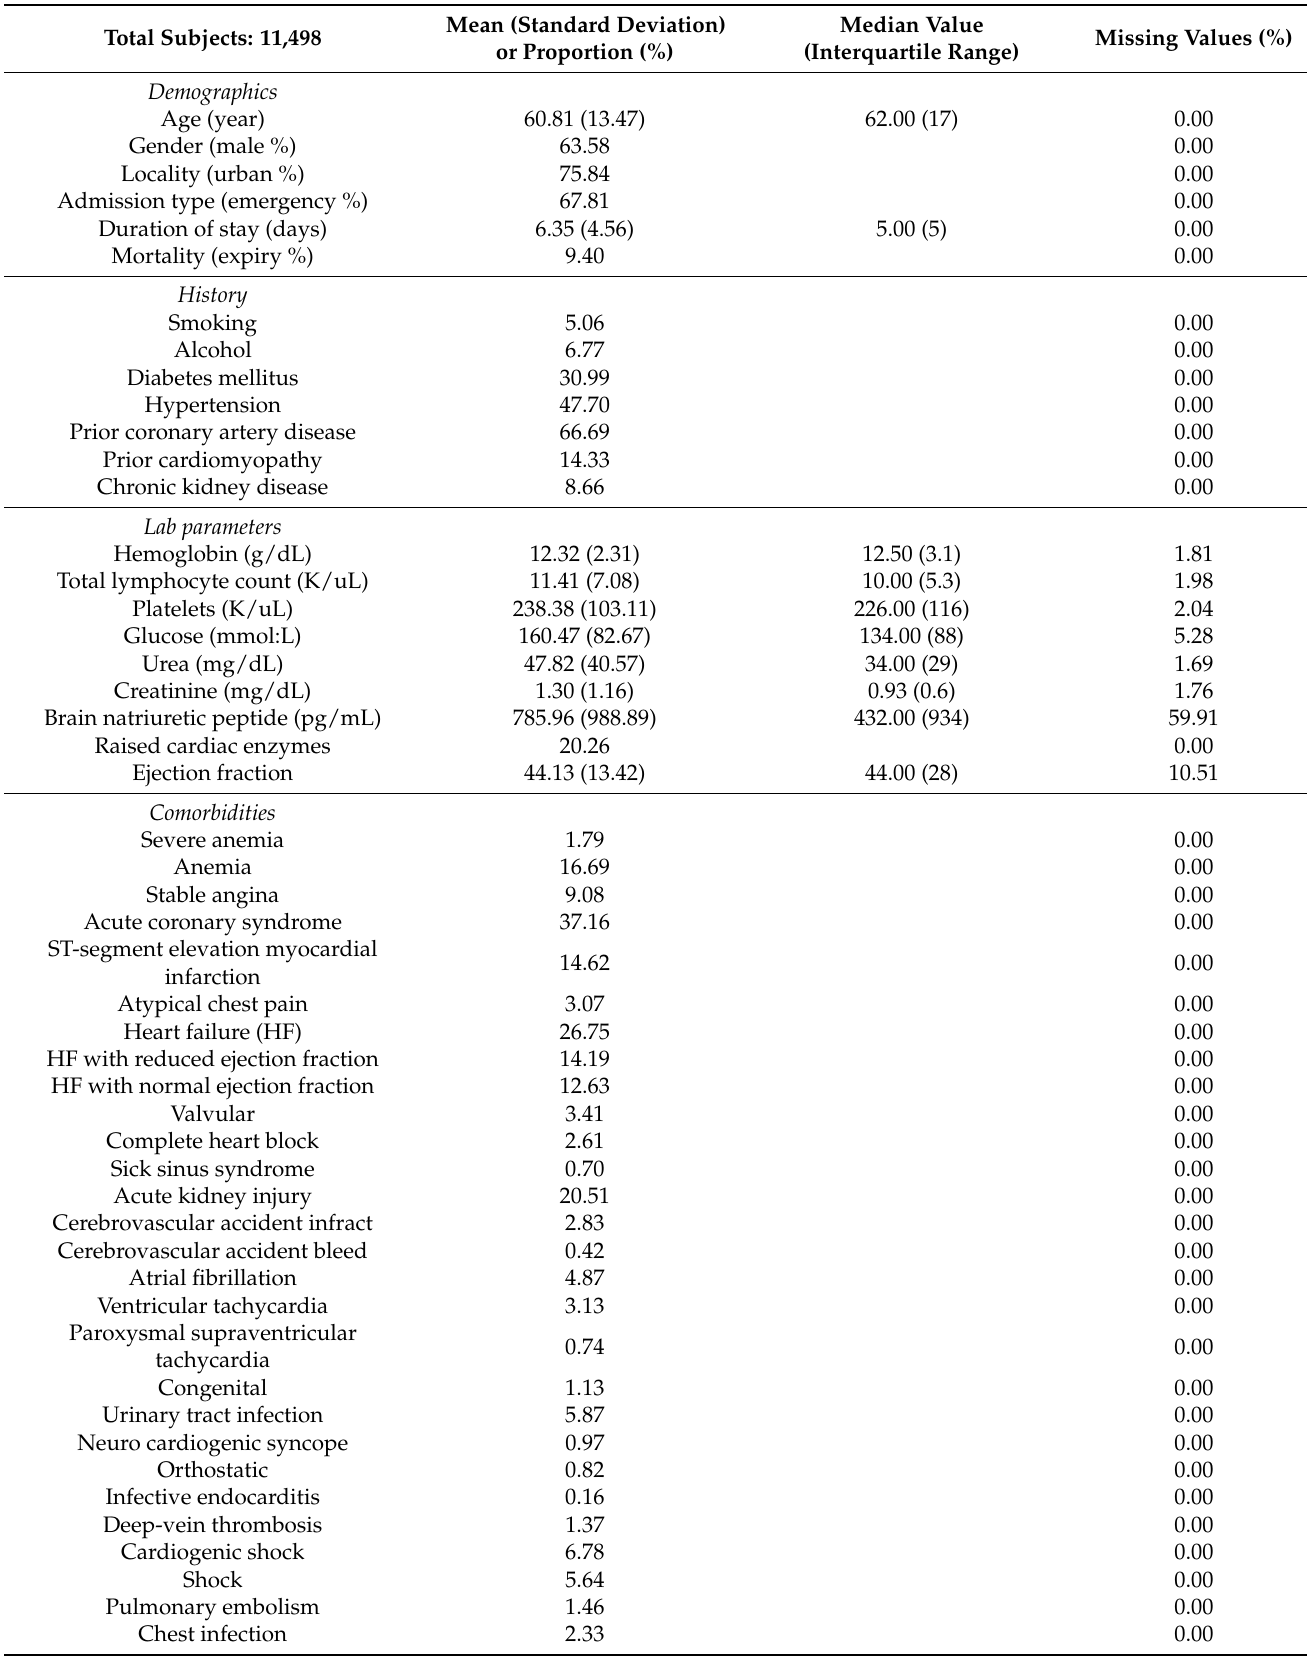
Table 1. Baseline patient